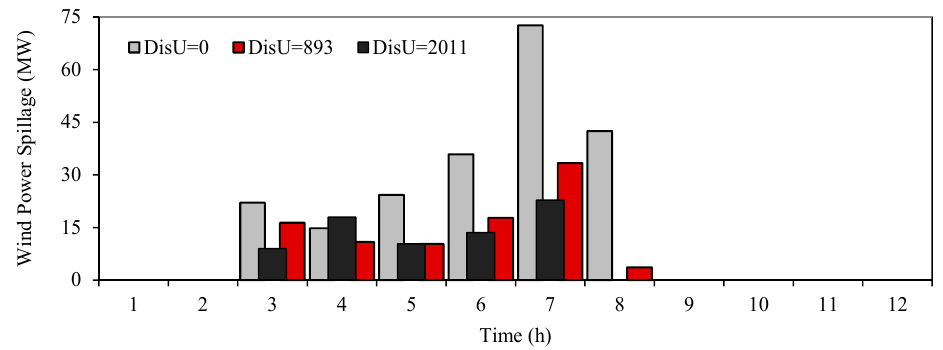
Figure 7. Hourly wind power spillage for the given case studies.